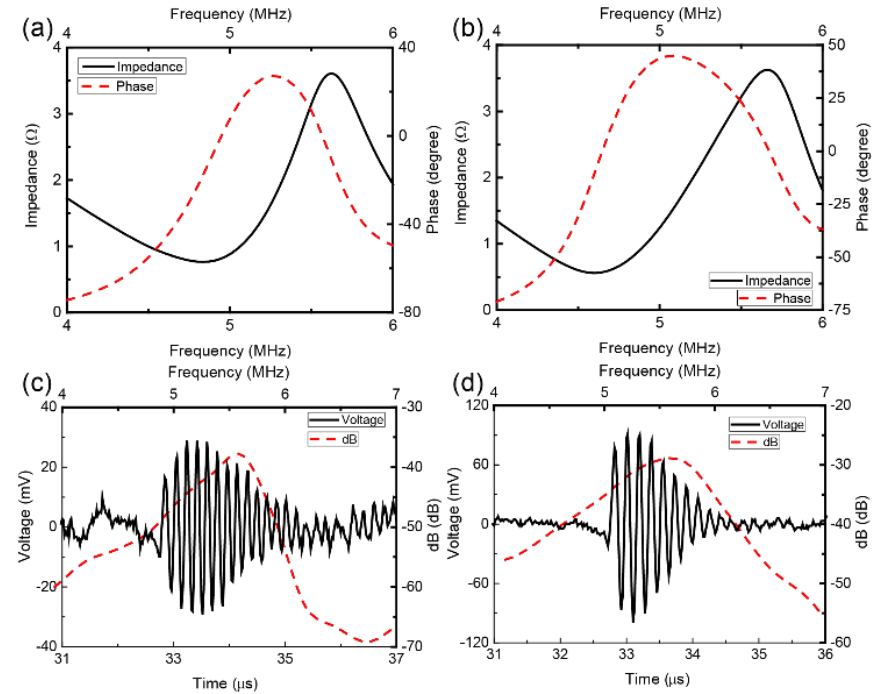
Figure 6. Top, frequency dependence of electrical impedance and phase plots of ( a ) the transducers with Fresnel lens and ( b ) without Fresnel lens; Bottom, measured pulse-echo waveform with normalized frequency spectrum of ( c ) the transducers with Fresnel lens and ( d ) without Fresnel lens.